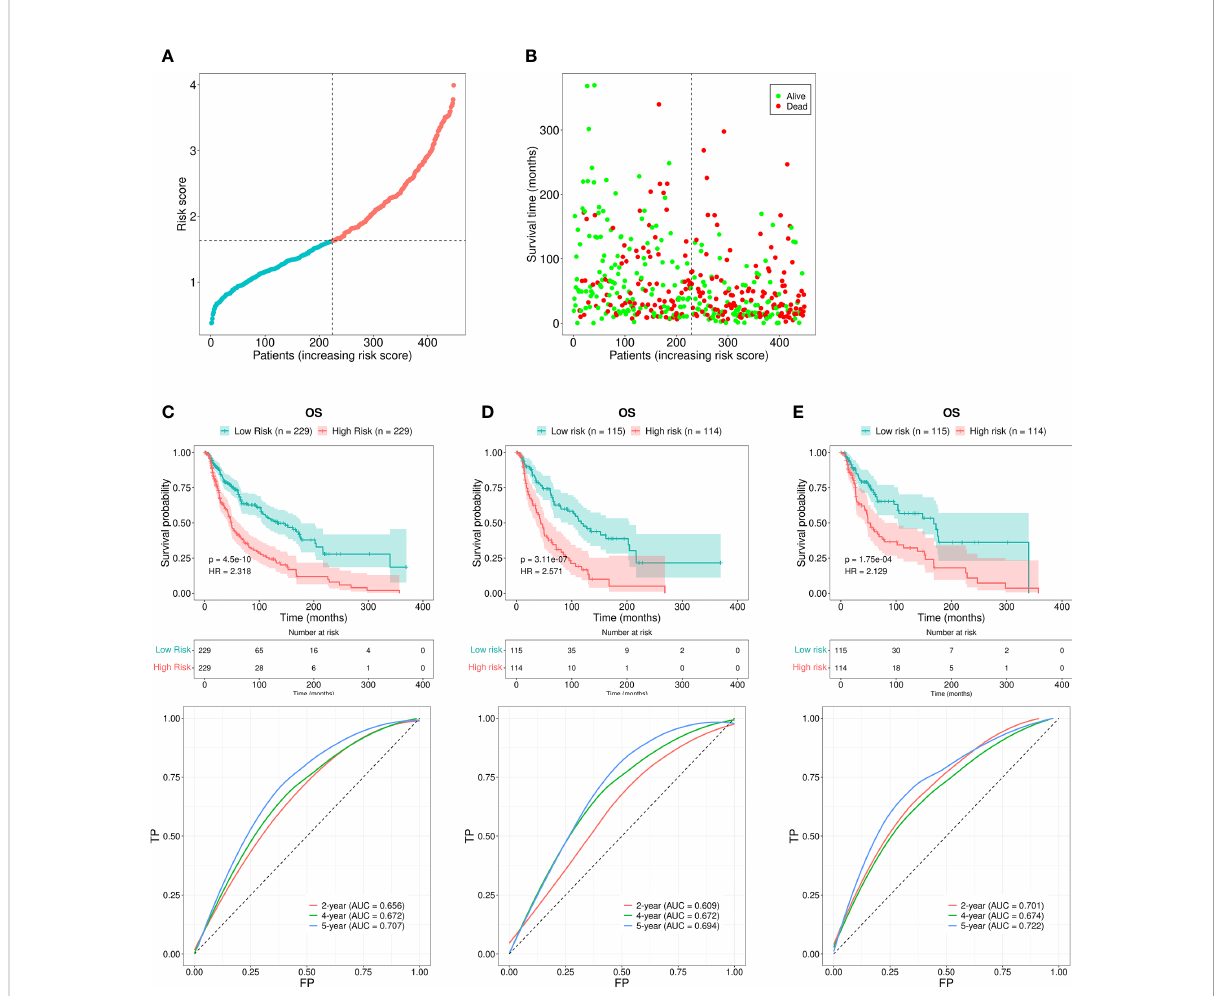
FIGURE 3 Risk assessment model for prognosis prediction. (A) The RS distribution for the SKCM patients. (B) The number of patients with different RS who were alive or had died. A larger number of deaths were observed in the group with a higher RS. (C) The OS rates in patients with SKCM who were included in the LR and HR groups were evaluated using the Kaplan-Meier method. The ROC curves as well as the AUCs at 2-, 4-, and 5- year survival as the predictive signature. (D) The OS rate for SKCM patients in the fi rst internal cohort, as assessed using the Kaplan-Meier method; ROC curves and AUCs at 2-, 4-, and 5-year survival as the predictive signature. (E) The SKCM patient OS rate in the second internal cohort was determined using the Kaplan-Meier method; the ROC curves and AUCs at 2-, 4-, and 5-year survival as the predictive